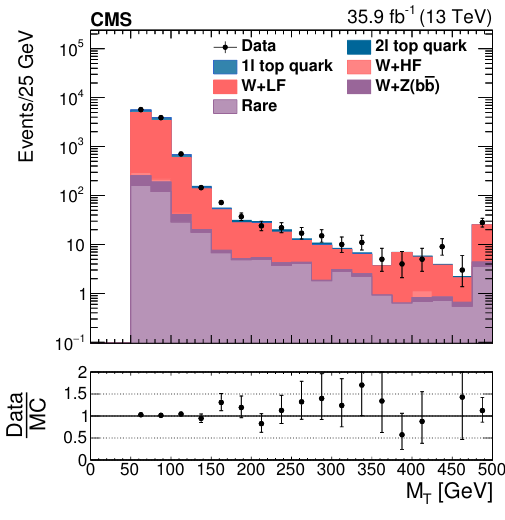
Figure 4 . Distribution in M T in CR0b after the preselection level cuts de(cid:12)ned in table 1. to o(cid:11)-shell W production or E miss